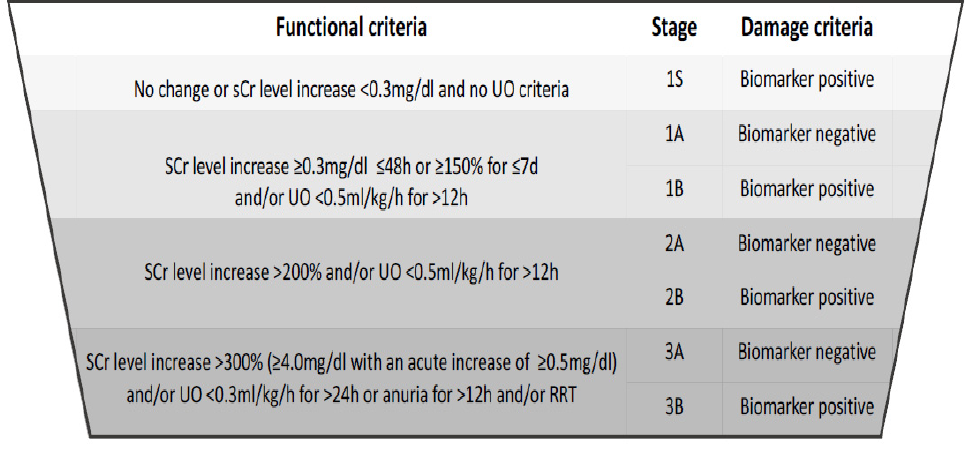
Figure 2. New, biomarker-enhanced definition of acute kidney injury according to the Acute Disease Quality Initiative Consensus Conference proposal, modified from Ostermann et al.